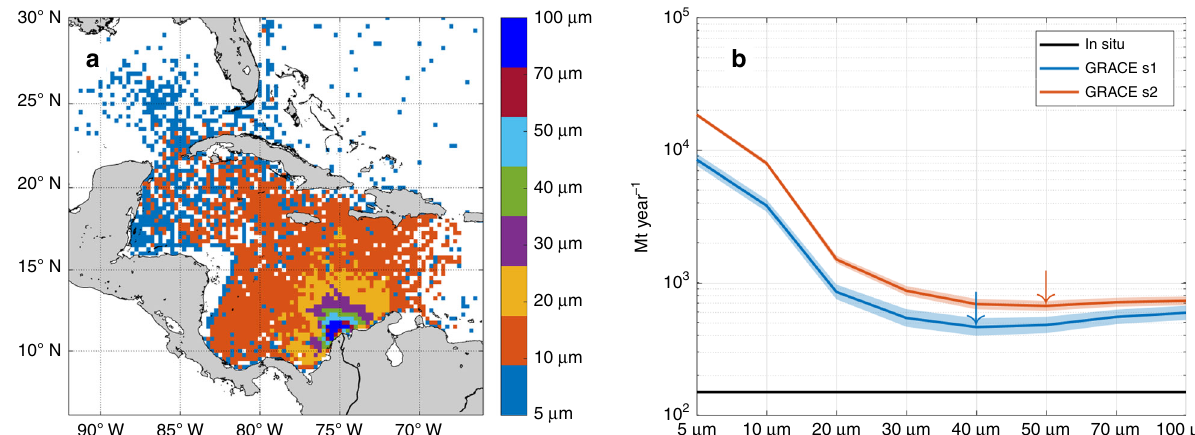
Fig. 3 Example of the grain size control of the modeled sediment distribution at the Magdalena river. a Sedimentation area decreases when grain size increases due to a faster sink relative to the horizontal advection capability of the sea currents. b In fl uence of the grain size on the SSD. For the Magdalena, SSD is closer to the in situ sediment discharges when grain size is around 40 – 50 µ m (see blue and red arrows for s1 and s2 solutions, respectively) and in any case larger than 40 µ m. Results at the other 12 rivers are in Supplementary Fig. 6. The hue around each GRACE solution represents the uncertainty derived from the signal (sediment) to noise (GRACE data) analysis (see (Supplementary Fig. 2). The second factor is the settling velocity of the particles, which is a function of their density and size. The density is kept constant (2500 kg m − 3 ) but reasonable grain sizes ranging from 5 to 100 µm (silt to very fi ne sand) are tested for each studied river.